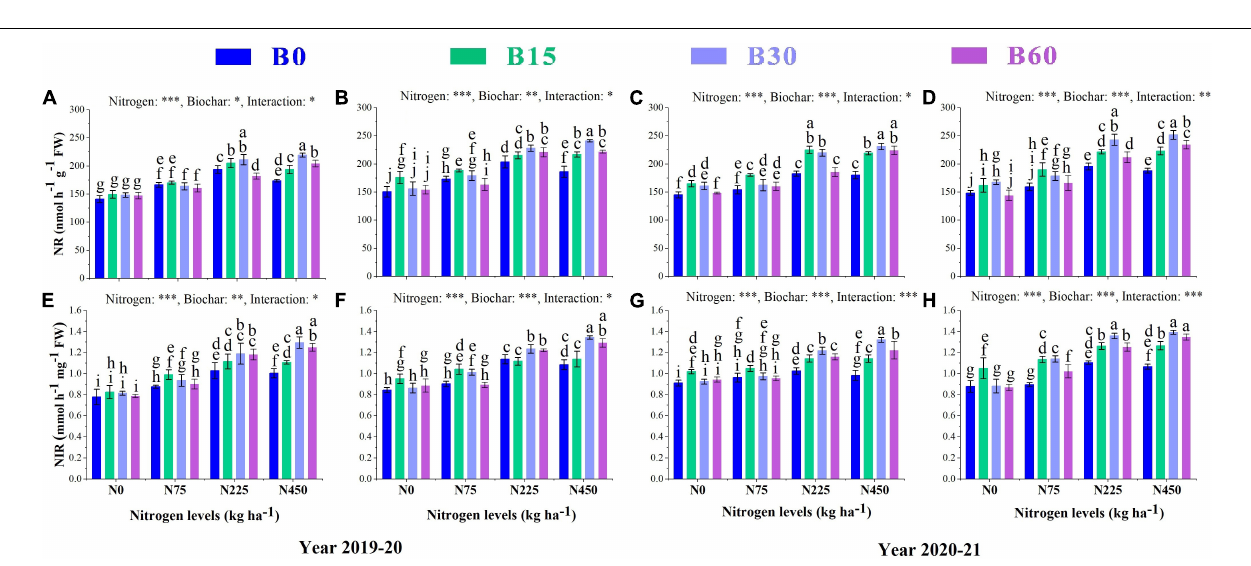
FIGURE 2 | Integral effects of biochar and nitrogen on nitrate reductase NR (A) SS, (B) FS in 2019–2020 and (C) SS, (D) FS in 2020–2021 and nitrite reductase (E) SS, (F) FS in 2019–2020 and (G) SS, (H) FS in 2020–2021. SS: seedling stage, FS: flowering stage. B0: 0 t ha − 1 biochar; B15: 15 t ha − 1 biochar; B30: 30 t represent standard error for each treatment in three replicates. Different letters on each bar represent significant differences according to the LSD test ( p <